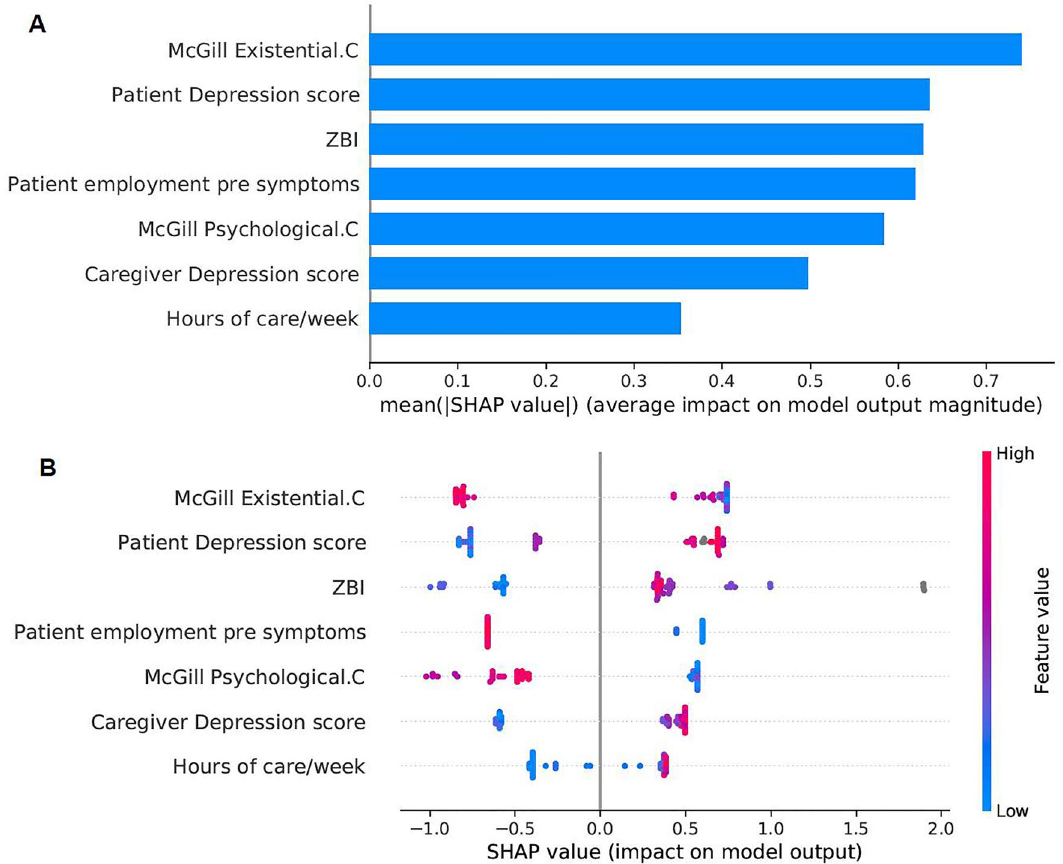
Figure 3. Bar plot and summary plot of model M7 for the identification of predictors of caregiver QoL. ( A ) Bar plot showing features in order of importance based on the mean absolute value of the SHAP values for each feature. ( B ) Summary plot where features appear in order of their sum of SHAP value magnitudes, and SHAP values show the impact each feature has on the model output. The colour represents the feature value (red high, blue low). The suffix “.C” represents a caregiver